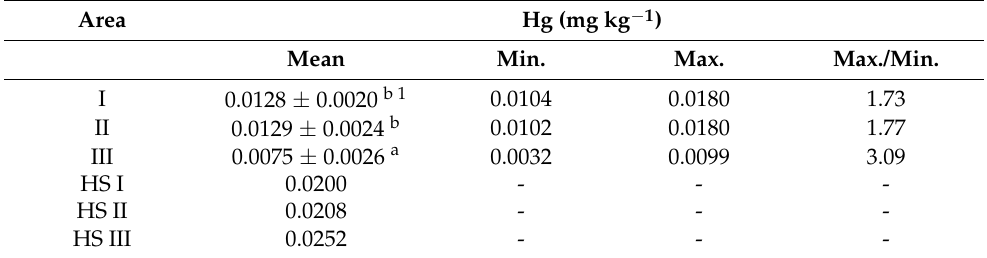
Table 4. Hg content in pine foliage in designated areas, on the basis of